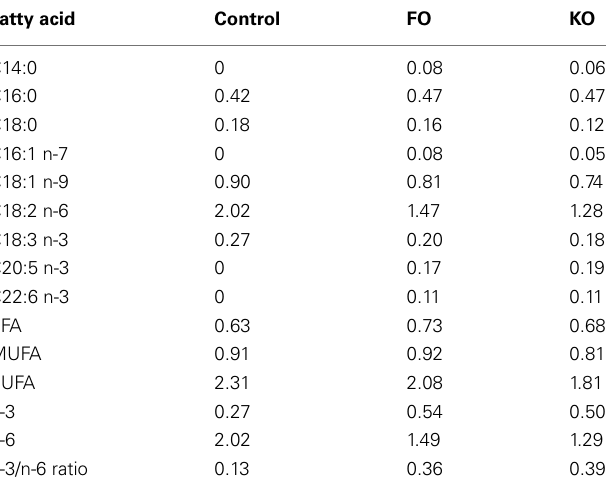
diets as determined from reference values for the different lipid